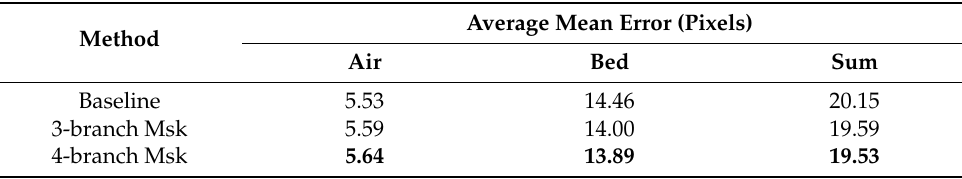
Table 4. Results of different branches in Msks with 7-frame input